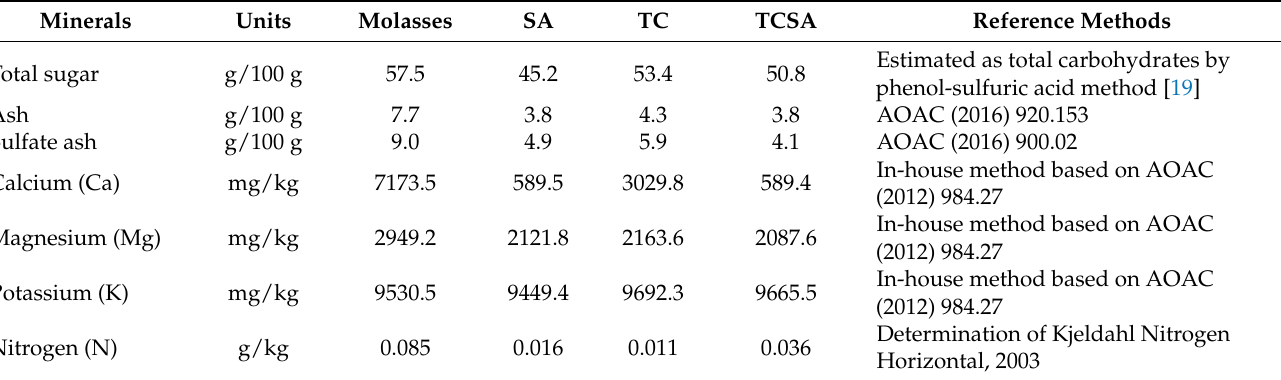
Table 2. The concentrations of mineral ions and total sugar in cane molasses before and after various pretreatment